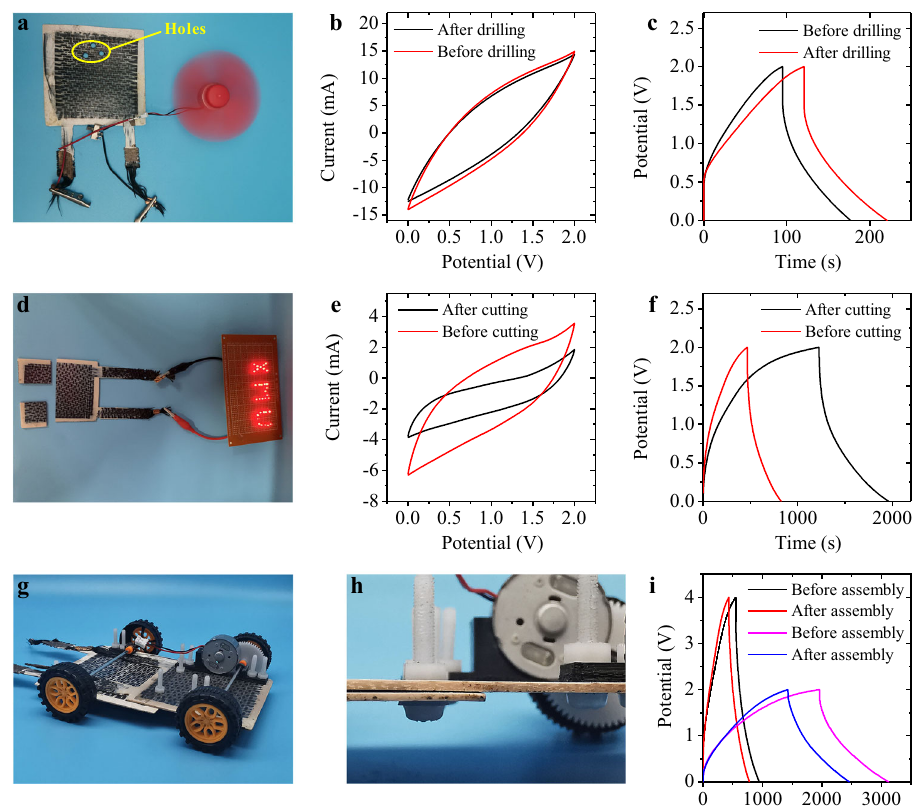
Fig. 6 | Secondary processing of LEIDs.a The photo of adrilled LEID-3asapower source to drive a fan. b , c CV curves ( b ) and GCD curves ( c ) at current density of 0.5mAcm − 2 ofLEID-3 before and after drilling. d The photo of a LEID-3 lighting up the LEDs after being cut into thrr pieces. e , f CV curves (50mVs − 1 ) ( e ) and GCD ( f )